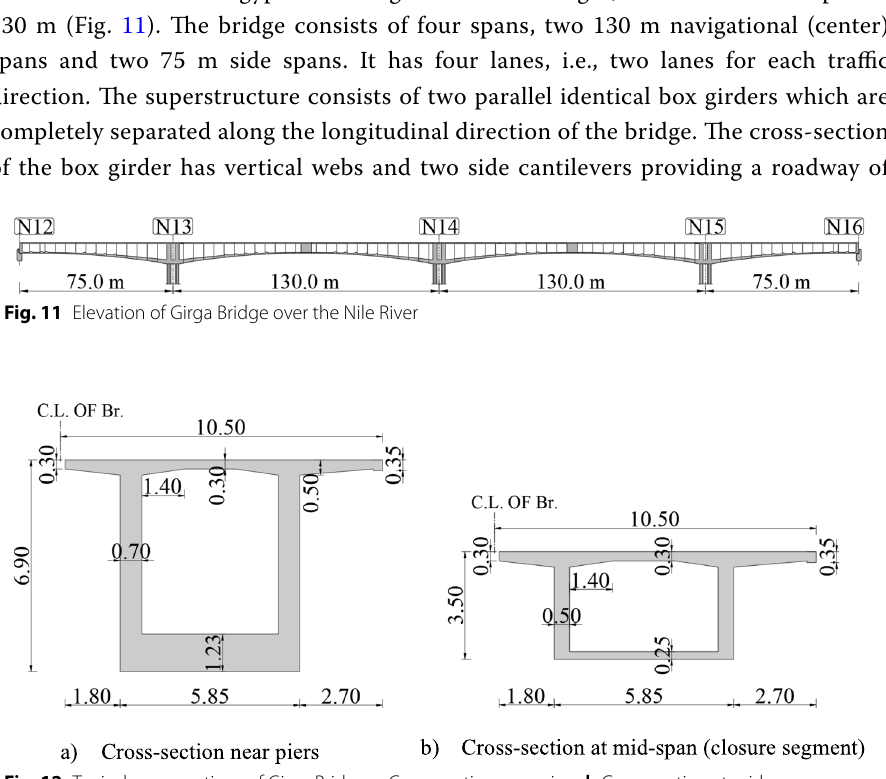
Fig. 12 Typical cross-sections of Girga Bridge. a Cross-section near piers. b Cross-section at mid-span (closure